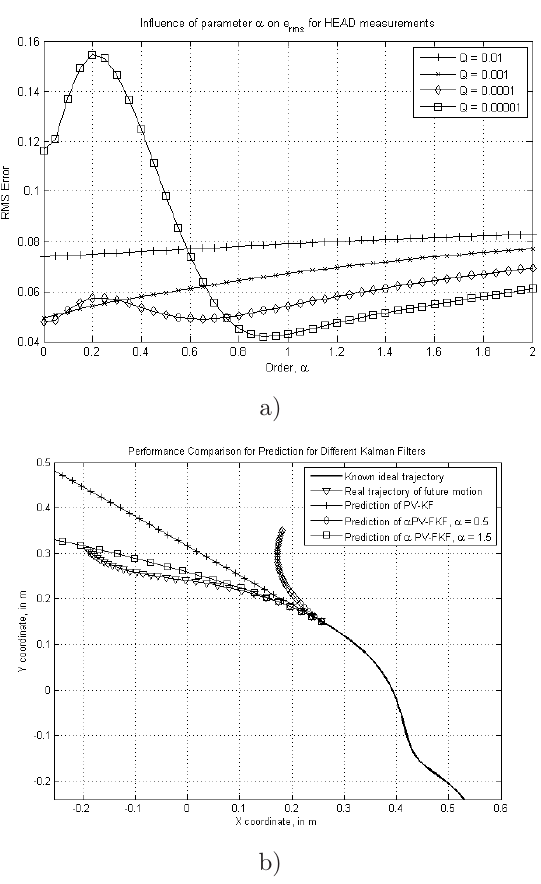
Figure 5. a) Influence of the model order α on the performance of the α P-FKF for different values of process noise Q : RMS error measure e rms for HEAD data set. Similar results are obtained for HAND data set; b) Performance of PV-KF and α P-FKF in predicting real hand motion (straight line corresponds to